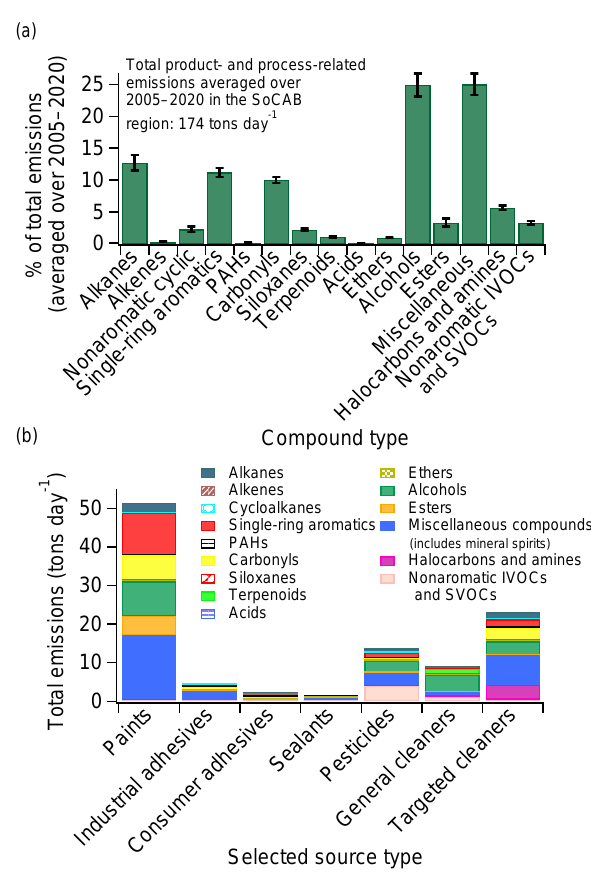
Figure 3. Average emissions from product- and process-related sources for 2005–2020 based on data from CARB inventory and SPECIATE database as a function of (a) compound class (shown with standard deviations) and (b) major product- and process- related source categories in the inventory (values in Table S3). “Mis- cellaneous” contains 70% mineral spirits (C 7 − 12 hydrocarbons). IVOCs and SVOCs do not include an estimate of the missing emis- sions identified in Sects. 2 and